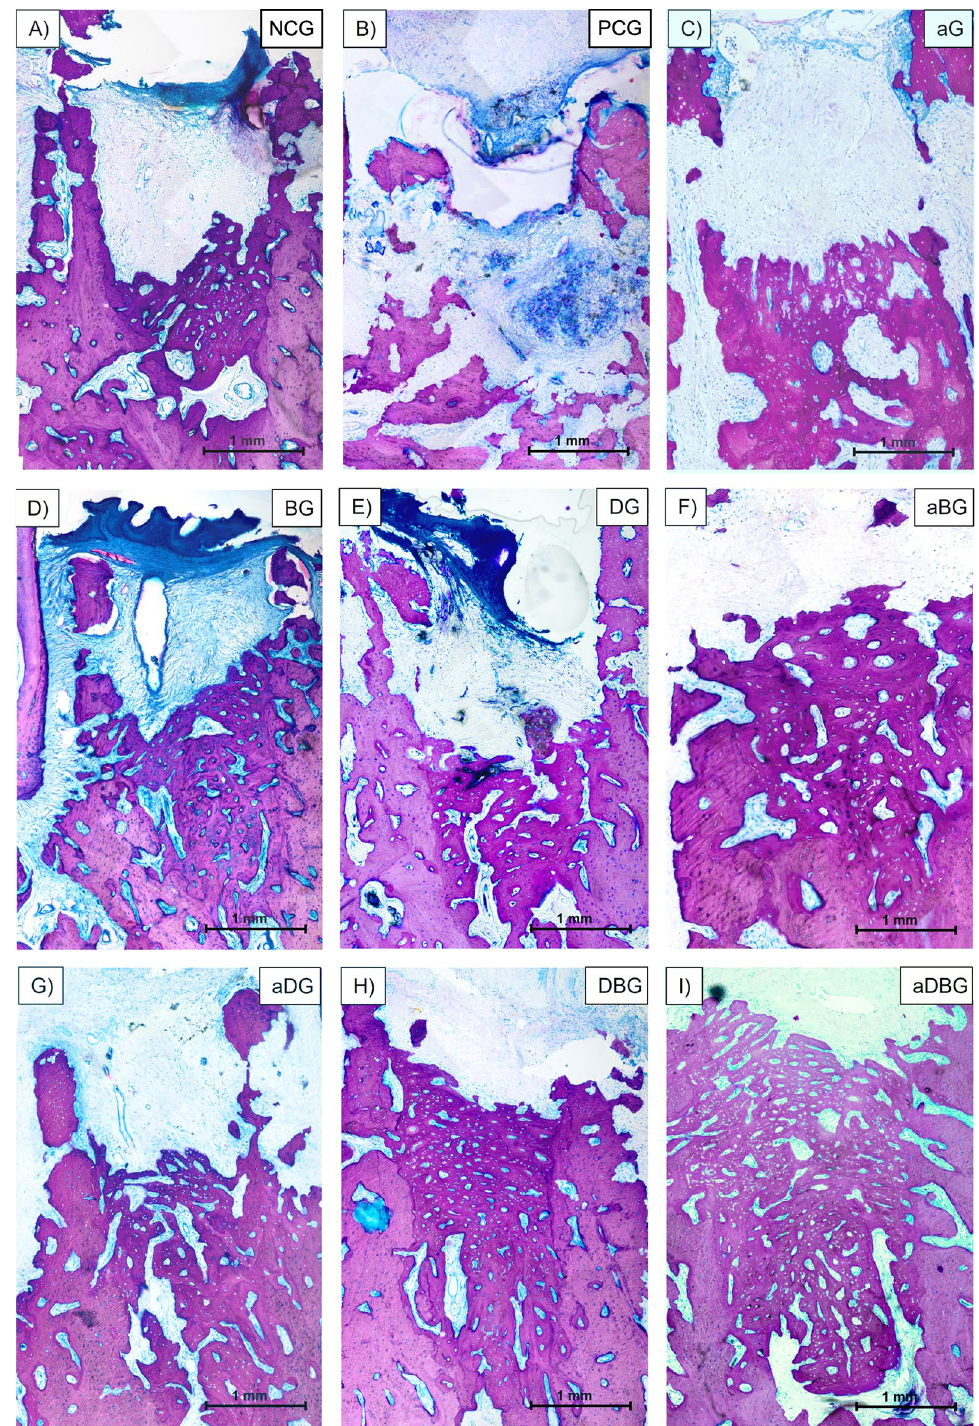
Figure 6. Representative photomicrographs of sections, stained in Stevenel’s blue and acidic fuchsin at 1.6 × magnification (blue, connective tissue; pink, mineralized tissue). Image ( A ) represents the NCG group, ( B ) PCG, ( C ) aG, ( D ) BG, ( E ) DG, ( F ) aBG, ( G ) aDG, ( H ) DBG, and ( I )